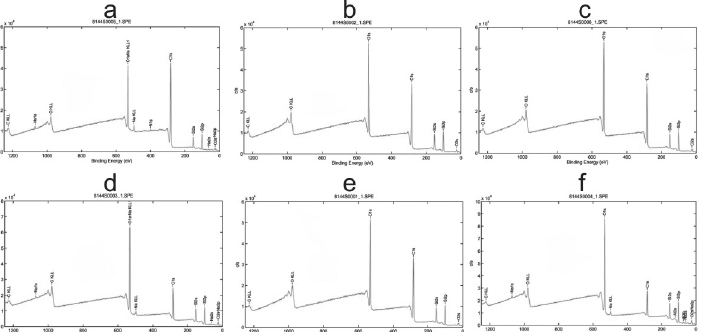
Figure 5- X-ray photoelectron spectrometer (XPS) spectra for the surfaces of untreated polymethylmethacrylate (a), Group A (b), Group S (c), Group SCSIL (d), Group SCA (e) and Group SCSILA (f)